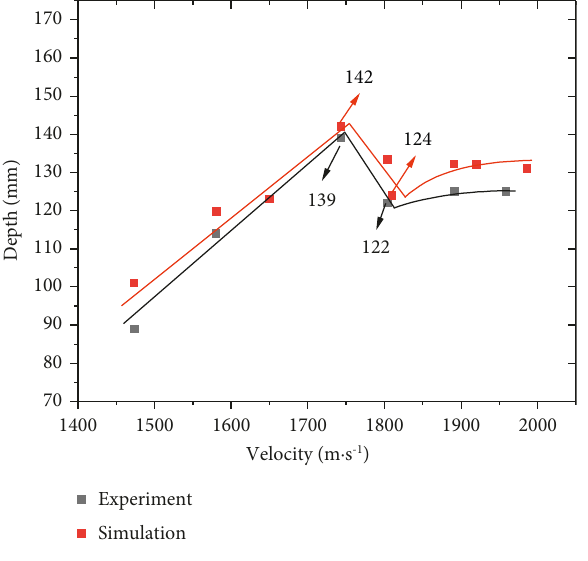
Figure 11: Time-course diagram of missile mass loss. Figure 10: Penetration depth vs.